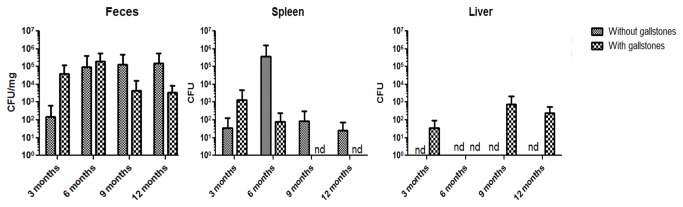

Salmonella detection in organs and bodily fluids of chronically infected mice up to 1 year post-infection.Bacterial CFU enumeration of Salmonella at various times post-infection in the absence and presence of gallstones. nd, not detected. Limit of detection was 100 CFU /mL. No statistically significant difference was observed between infected mice with or without gallstones at any time point (Student’s t test). nd, not detected.